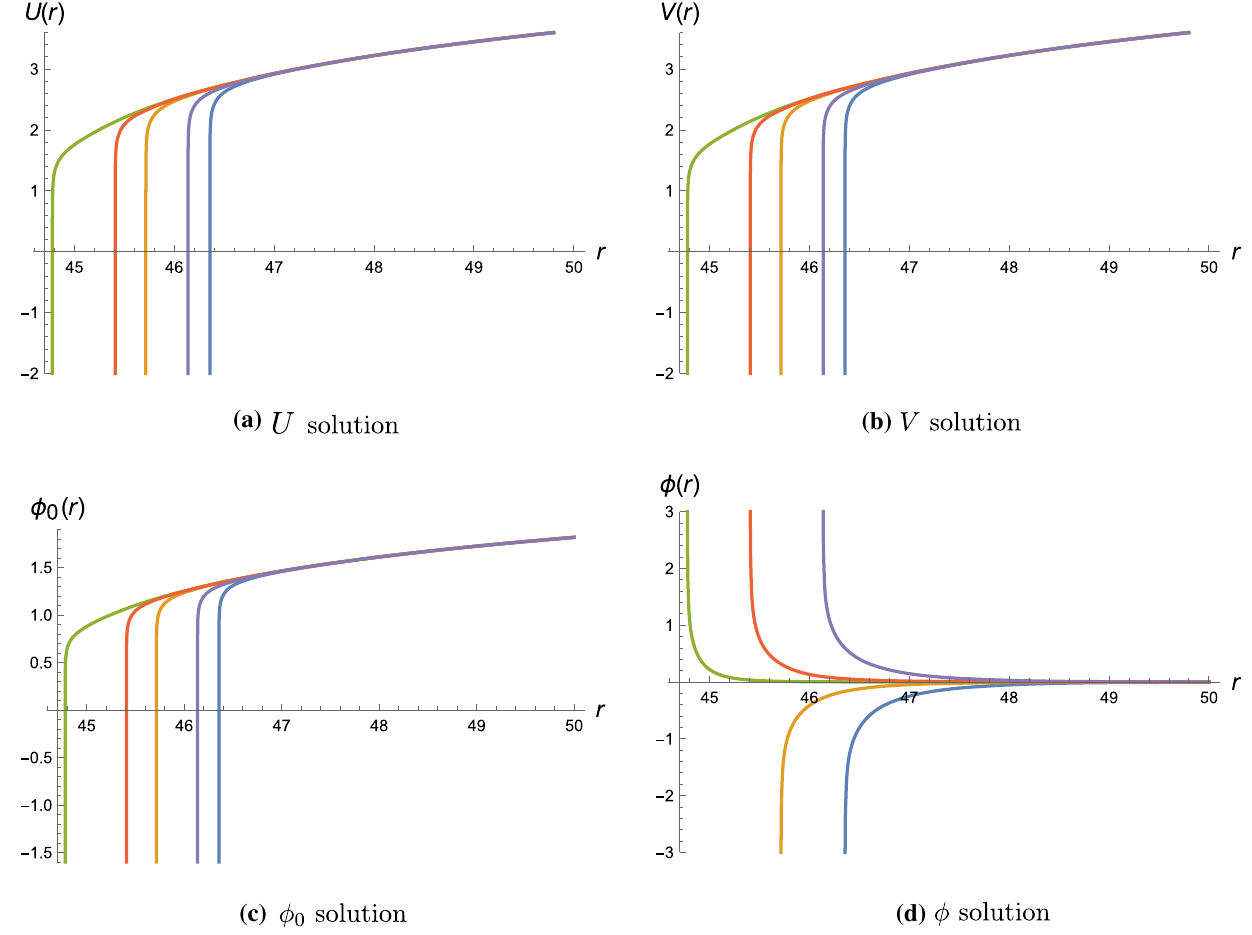
Fig. 33 Supersymmetric flows interpolating between asymptotically locally flat domain walls and Mk w 4 × H 2 -sliced curved domain walls for SO ( 2 ) × SO ( 2 ) twist in SO ( 4 ) gauge group. The blue, orange, green, red and purple curves refer to p 2 = − 0 . 5 , − 0 . 12 , − 0 . 03 , 0 , 0 . 25, respectively